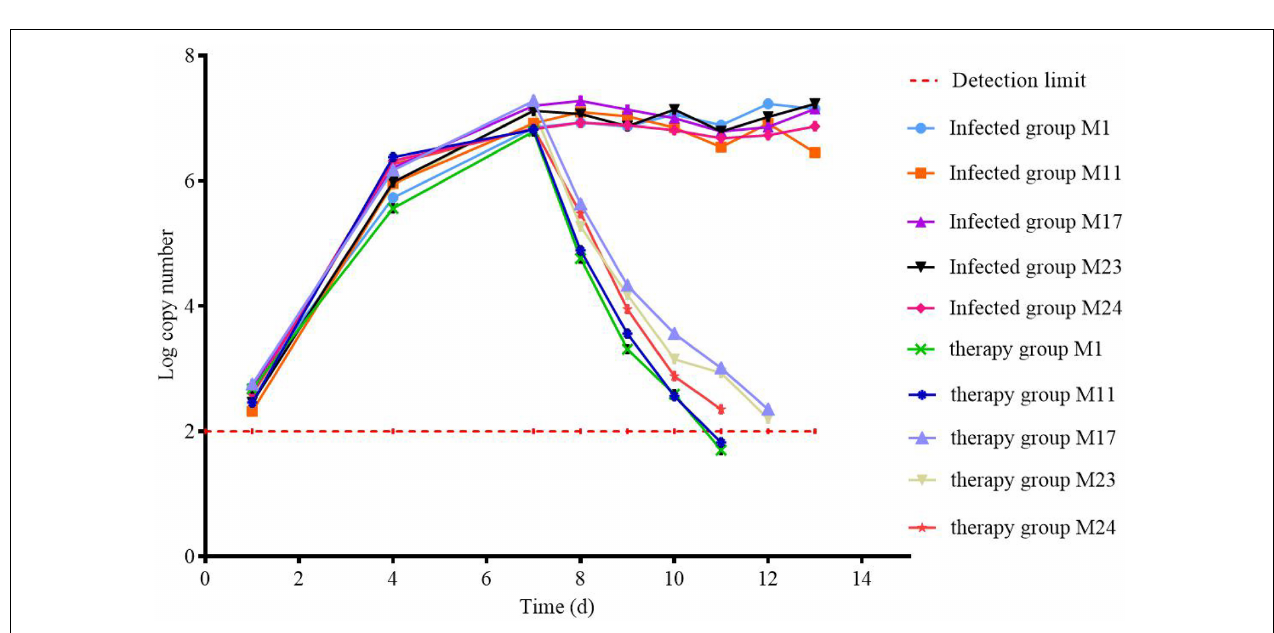
FIGURE 8 | The growth of bacteria under different drug regimens by Mlxplore simulation. (A) 3 days at intervals of 24 h. (B) 3 days at intervals of 12 h.